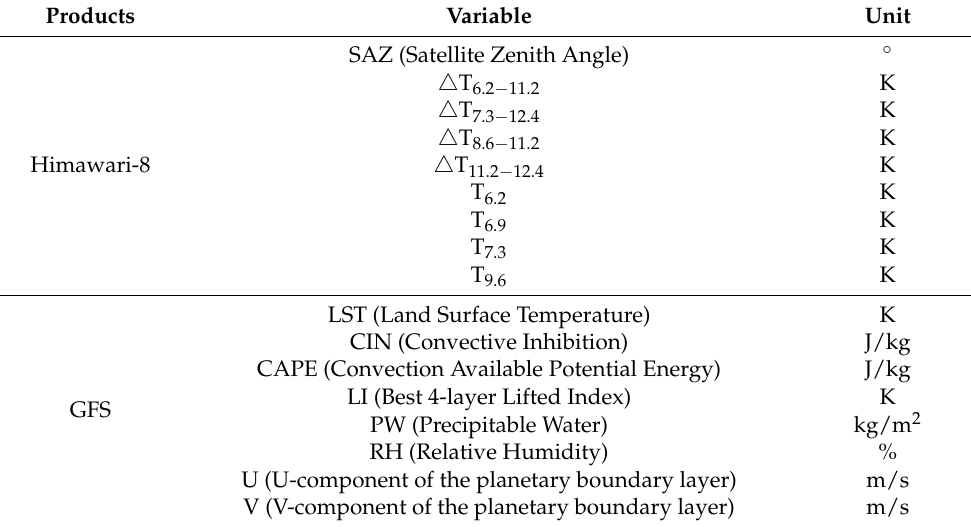
Table 1. The predictors used in the RF model for rain area determination.